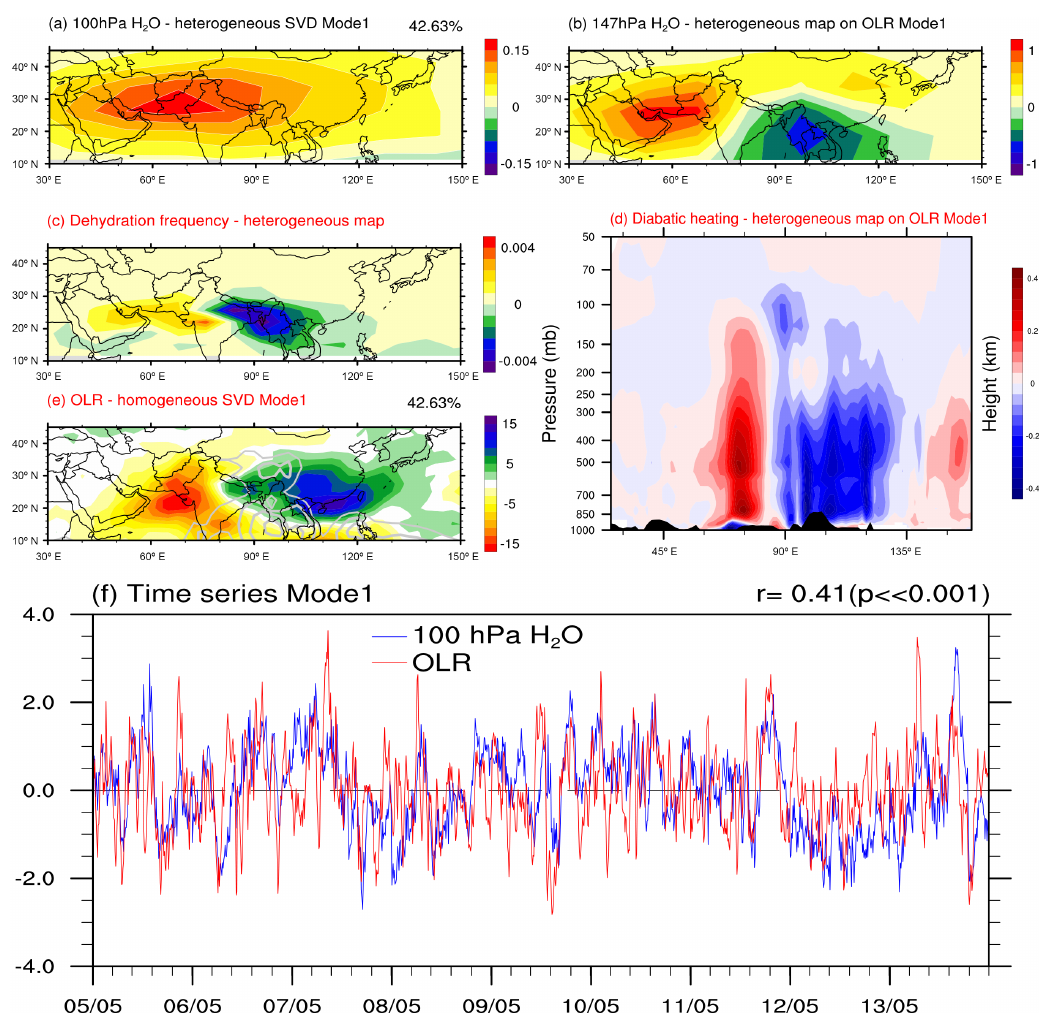
Figure 5. First SVD mode between water vapor anomalies (ppmv) and OLR anomalies (Wm − 2 ) over the Asian monsoon region. (a, b) Het- erogeneous map of water vapor at 100 and 147hPa on OLR SVD mode 1; (c) heterogeneous map of dehydration frequency derived from traj_ERAi on OLR SVD mode 1; (d) heterogeneous map of diabatic heating at 25 ◦ N on OLR SVD mode 1; (e) homogeneous map of OLR SVD mode 1; (f) standardized time series of 100hPa water vapor anomalies and OLR anomalies. Note that the color bar for OLR is